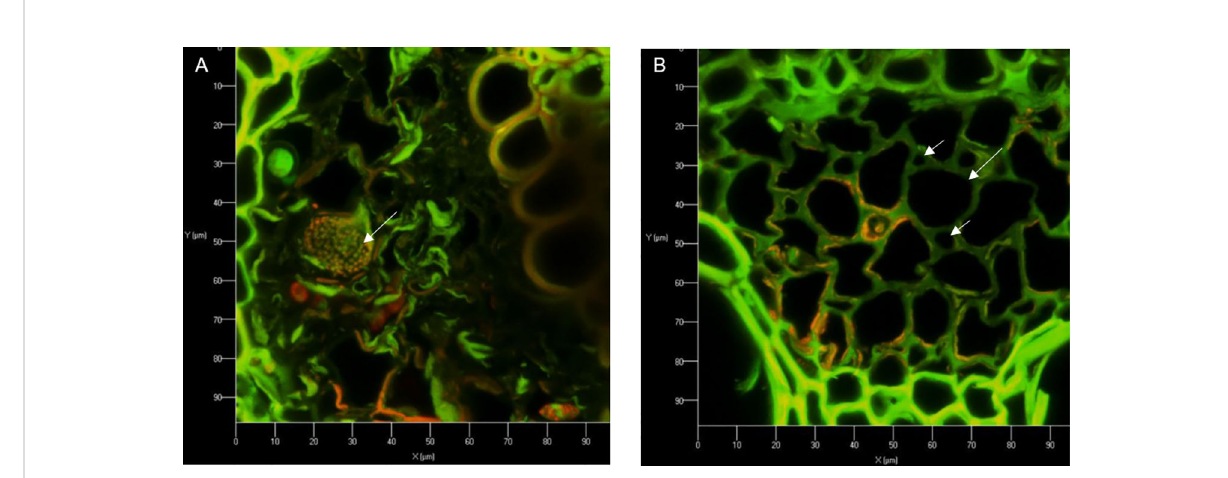
FIGURE 6 Vascular bundles of corn stem cross sections after being in culture with S. obliquus (A) or incubated with just BG-11 media (B) after fl uorescence staining with acridine orange. Long arrows point to sieve elements; short arrows point to companion cells.